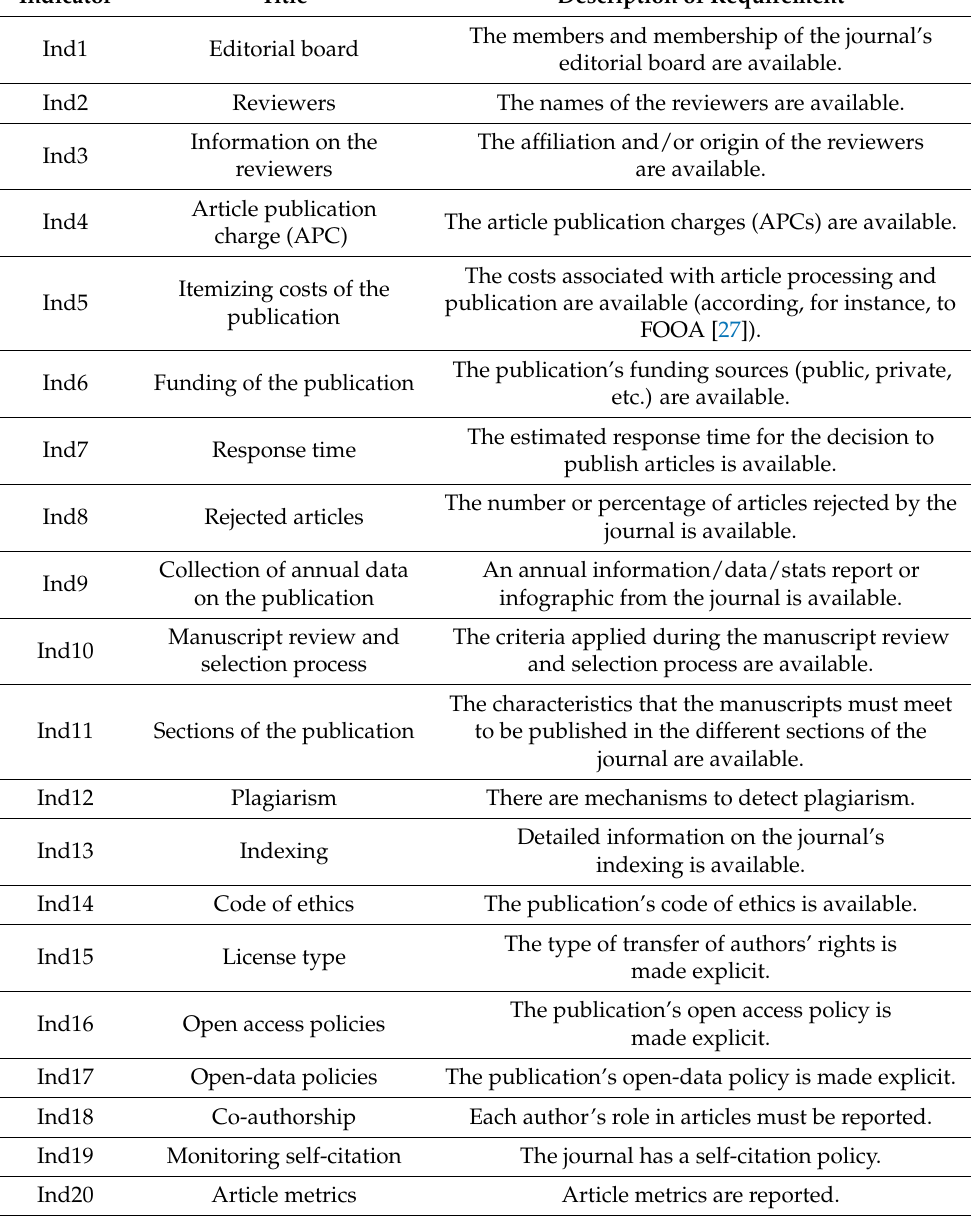
Table 1. List and description of the indicators used for analysis of the